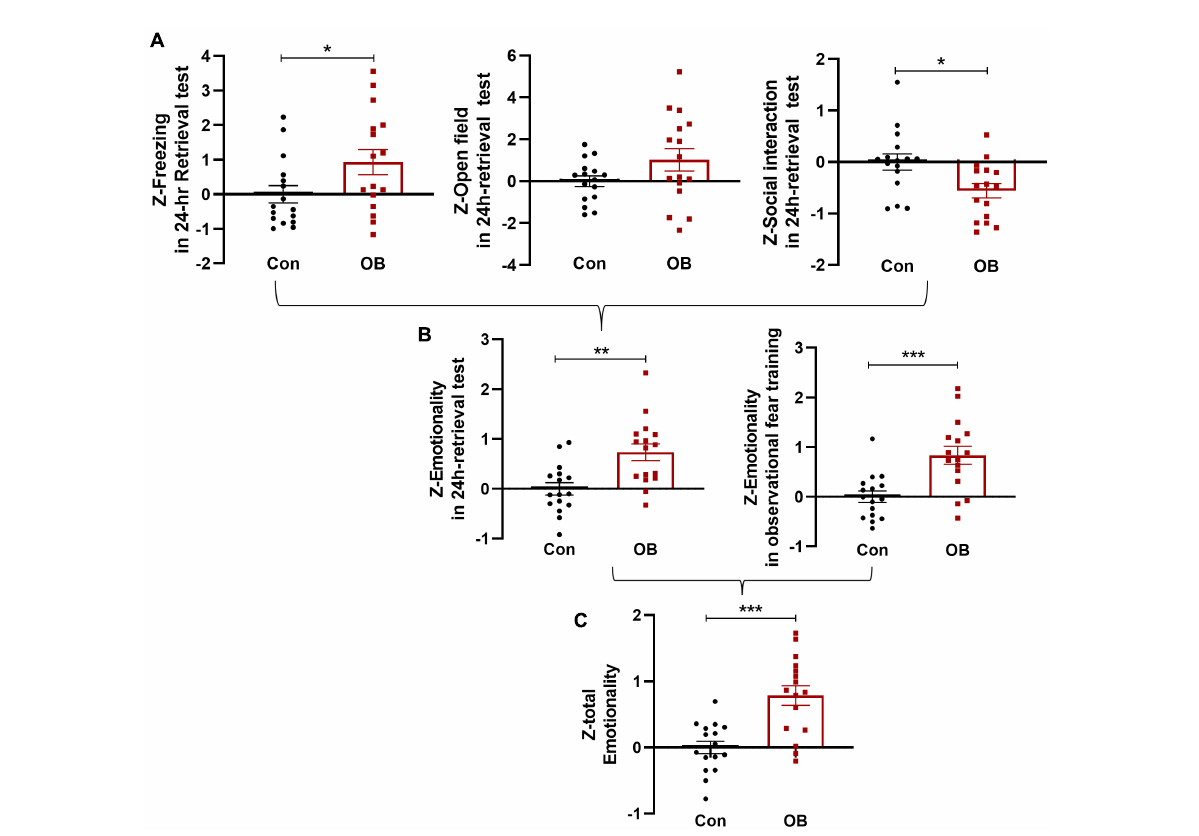
FIGURE6 Integrated total emotionality of training and testing day. (A) Raw data are obtained from three behavioral tests (FZ, OF, and SI) performed on the same animals. Normalization of data using the Z -score method was performed for each parameter. FZ, OF, and SI test Z -values were calculated on a 24-h retrieval testing day. (B,C) Z -scores on training and testing days were averaged to obtain an integrated total emotionality Z -score. Data are expressed as mean ± SEM ( n = 16) and compared by unpaired t -test. ∗ p < 0.05, ∗∗ p < 0.01, ∗∗∗ p < 0.001.